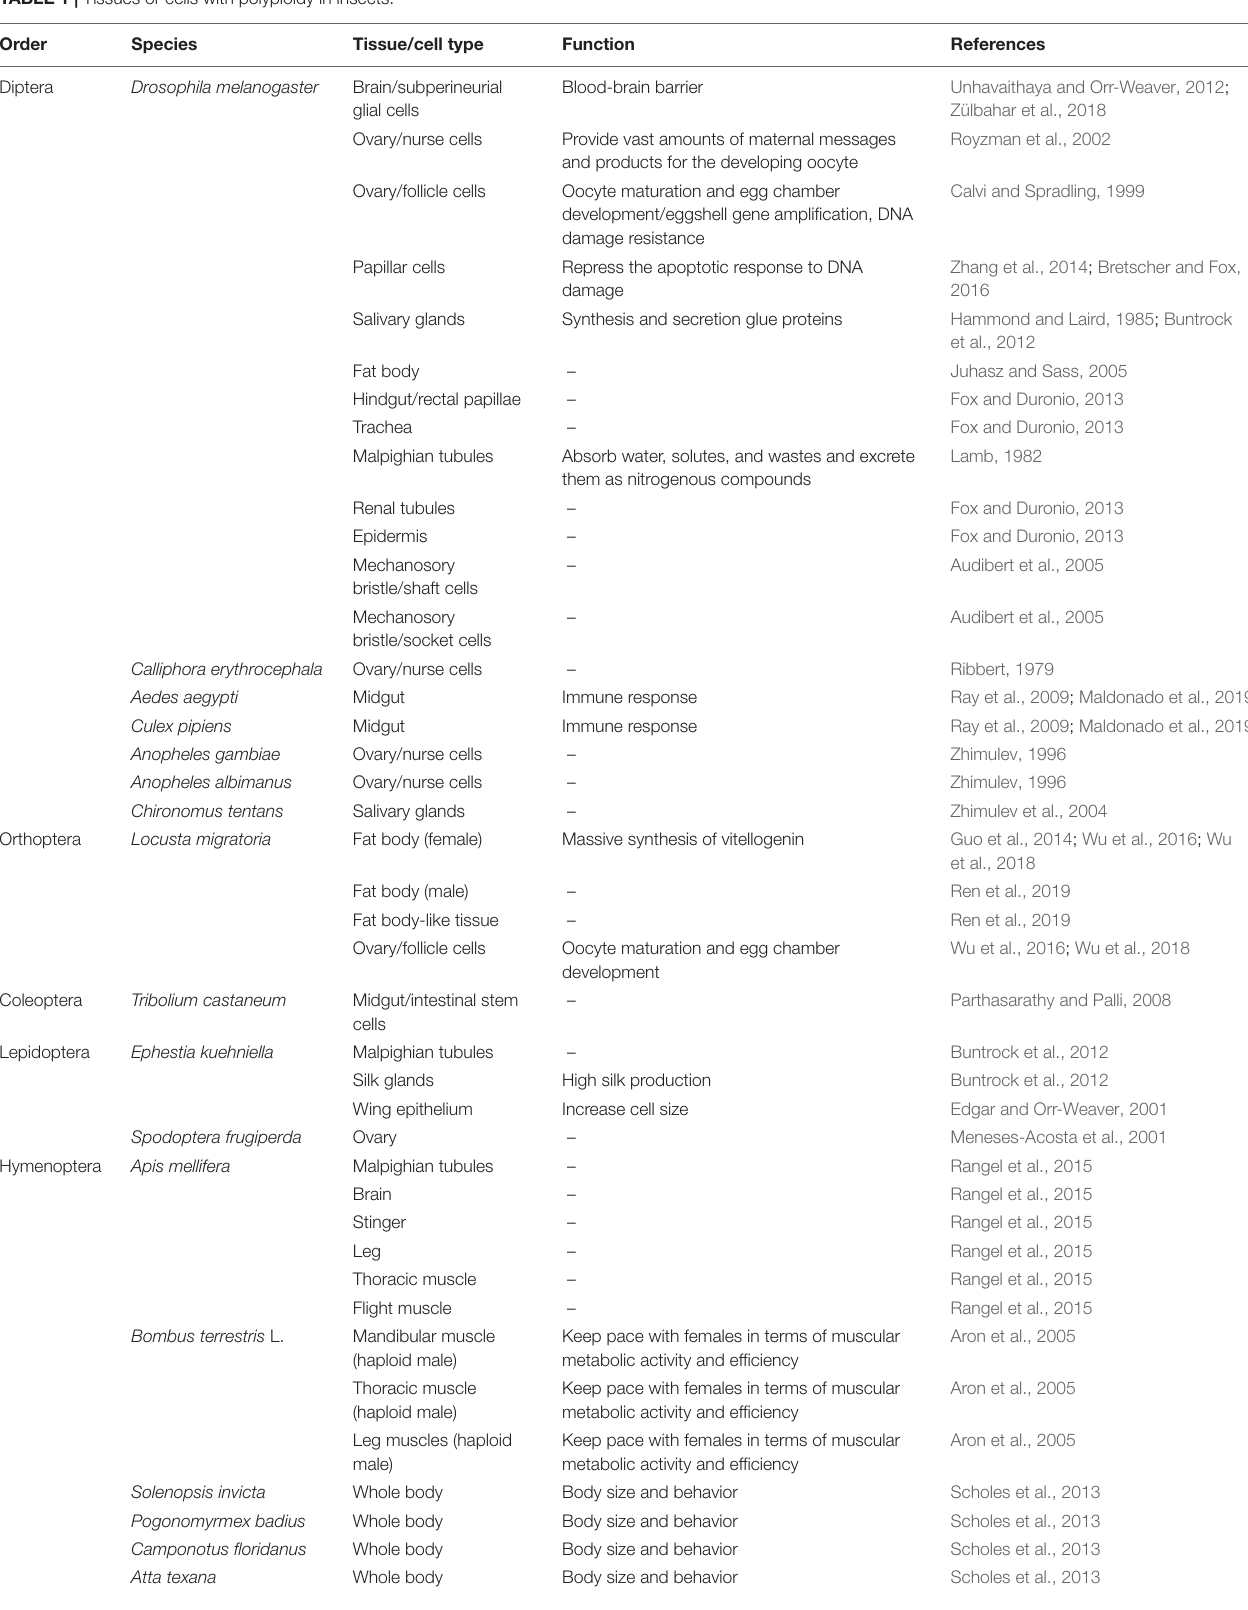
TABLE 1 | Tissues or cells with polyploidy in